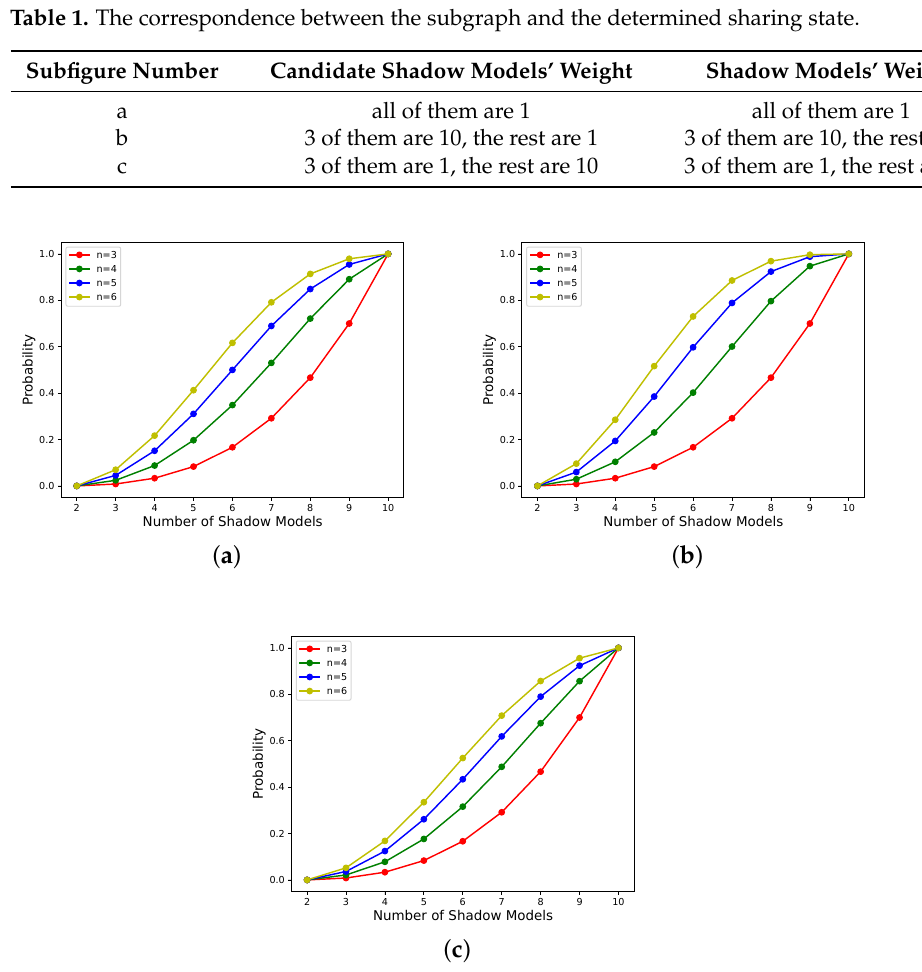
Figure 2. When k is constant, the relationship between x and P ( j (cid:62) k ) for different determined sharing states. ( a ) All candidate shadow models’ weights and shadow models’ weights are 1. ( b ) 3 of candidate shadow models’ weights are 10, and the rest are 1. 3 of shadow models’ weights are 10, and the rest are 1. ( c ) 3 of candidate shadow models’ weights are 1, and the rest are 10. 3 of shadow models’ weights are 1, and the rest are